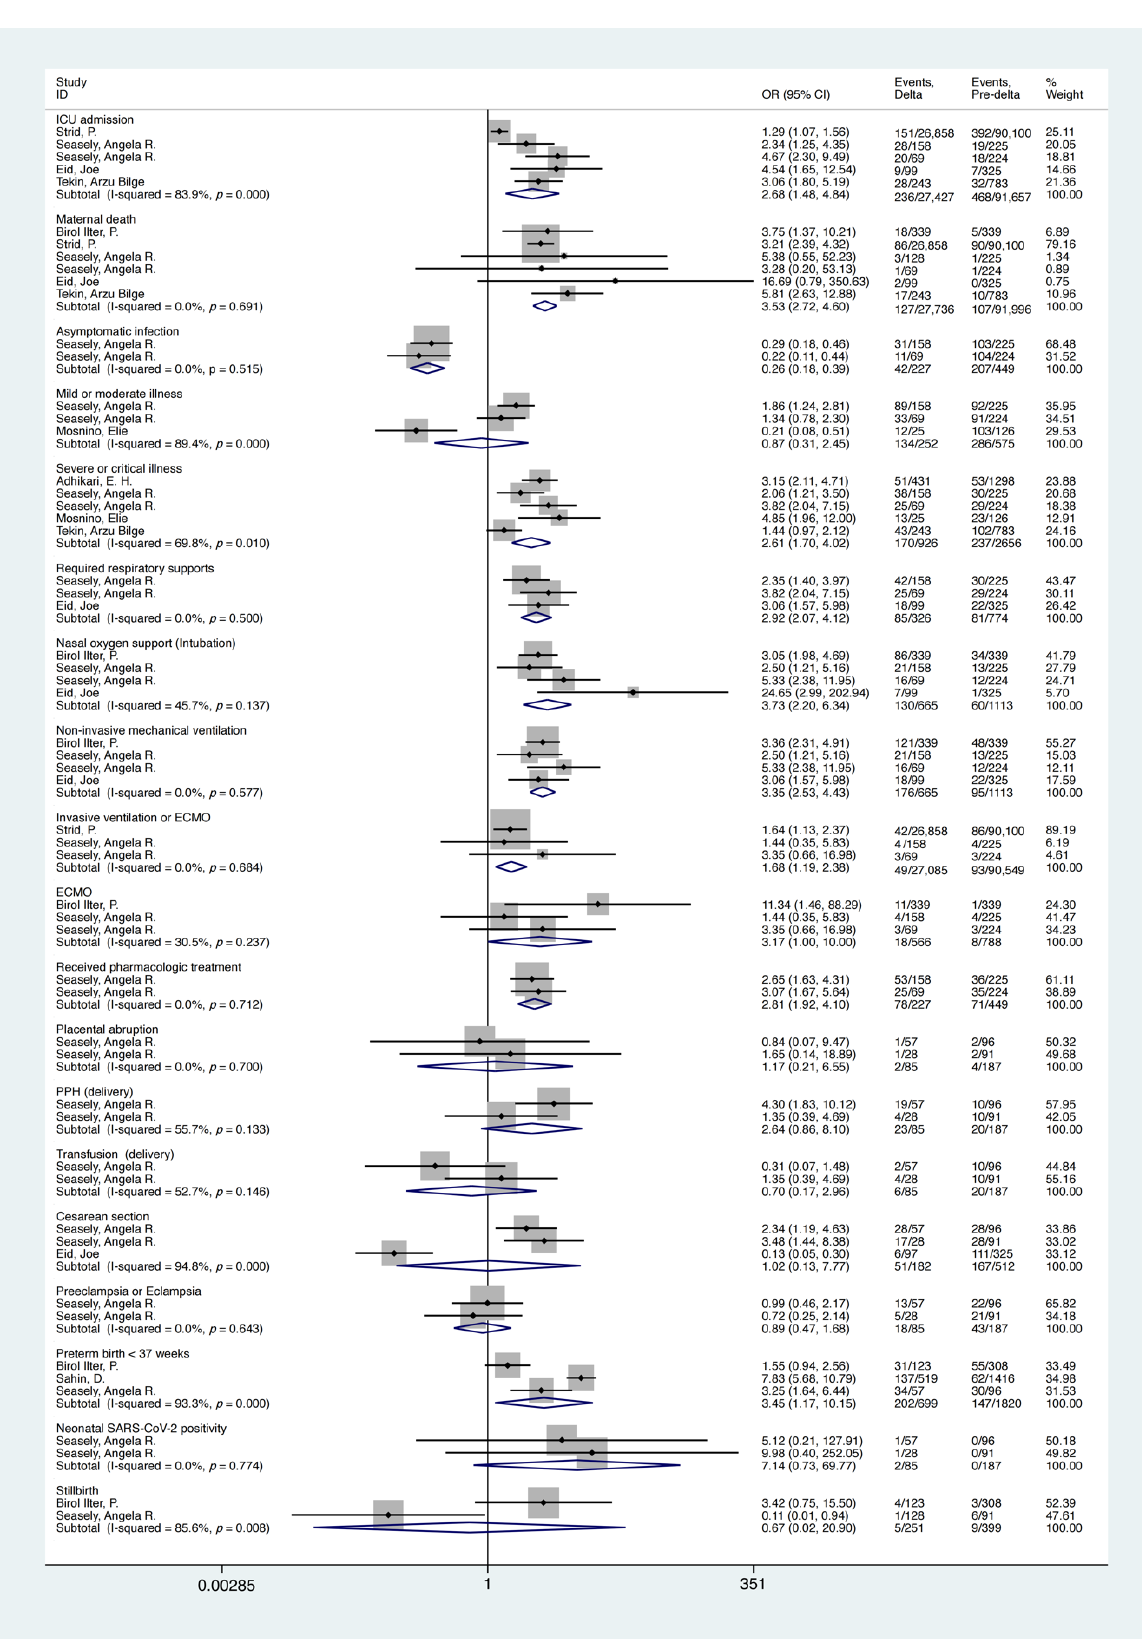
Figure 2. Forest plot of maternal and perinatal outcomes of Delta or pre-Delta SARS-CoV-2 variant infections during pregnancy. NOTE: Weights are from random effects analysis .